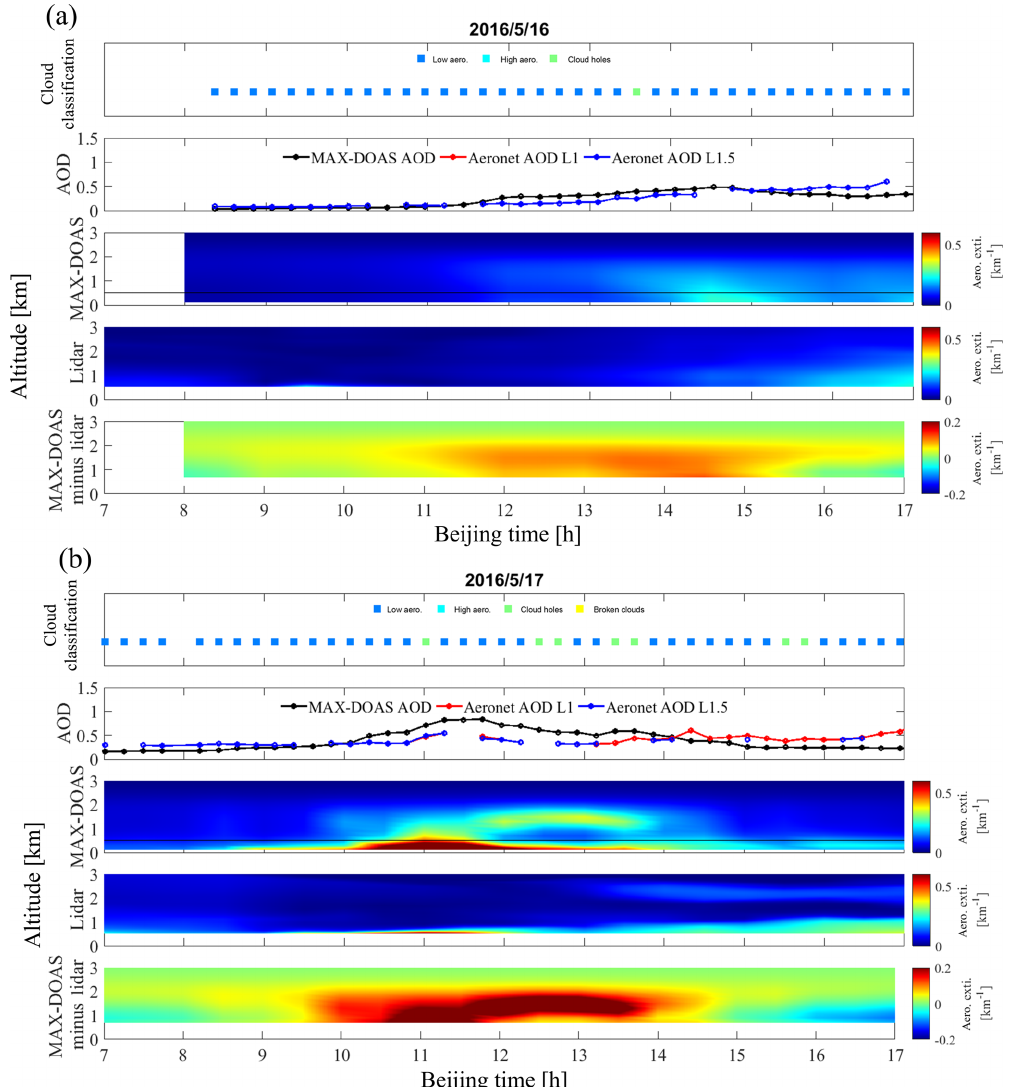
Figure 7. Vertical profiles of aerosol extinctions derived from MAX-DOAS and lidar measurements on 16 May 2016 (a) and 17 May 2016 (b) . Differences of aerosol extinction results between from MAX-DOAS and lidar measurements are also given at the bottom of both subfigures. Note that colour bar in the plots of differences is different from that in the plots of vertical profiles. Cloud classification results are shown at the top of both subfigures. AODs (black) are derived from the MAX-DOAS measurements and from the sun photometer. The red and blue lines shown in the second row are the level 1 (unscreened) and level 1.5 (cloud-screened and quality-controlled) products, respectively. The black line in the third subpanels in (a) and (b) marks the lower limit (500m) of the LIDAR